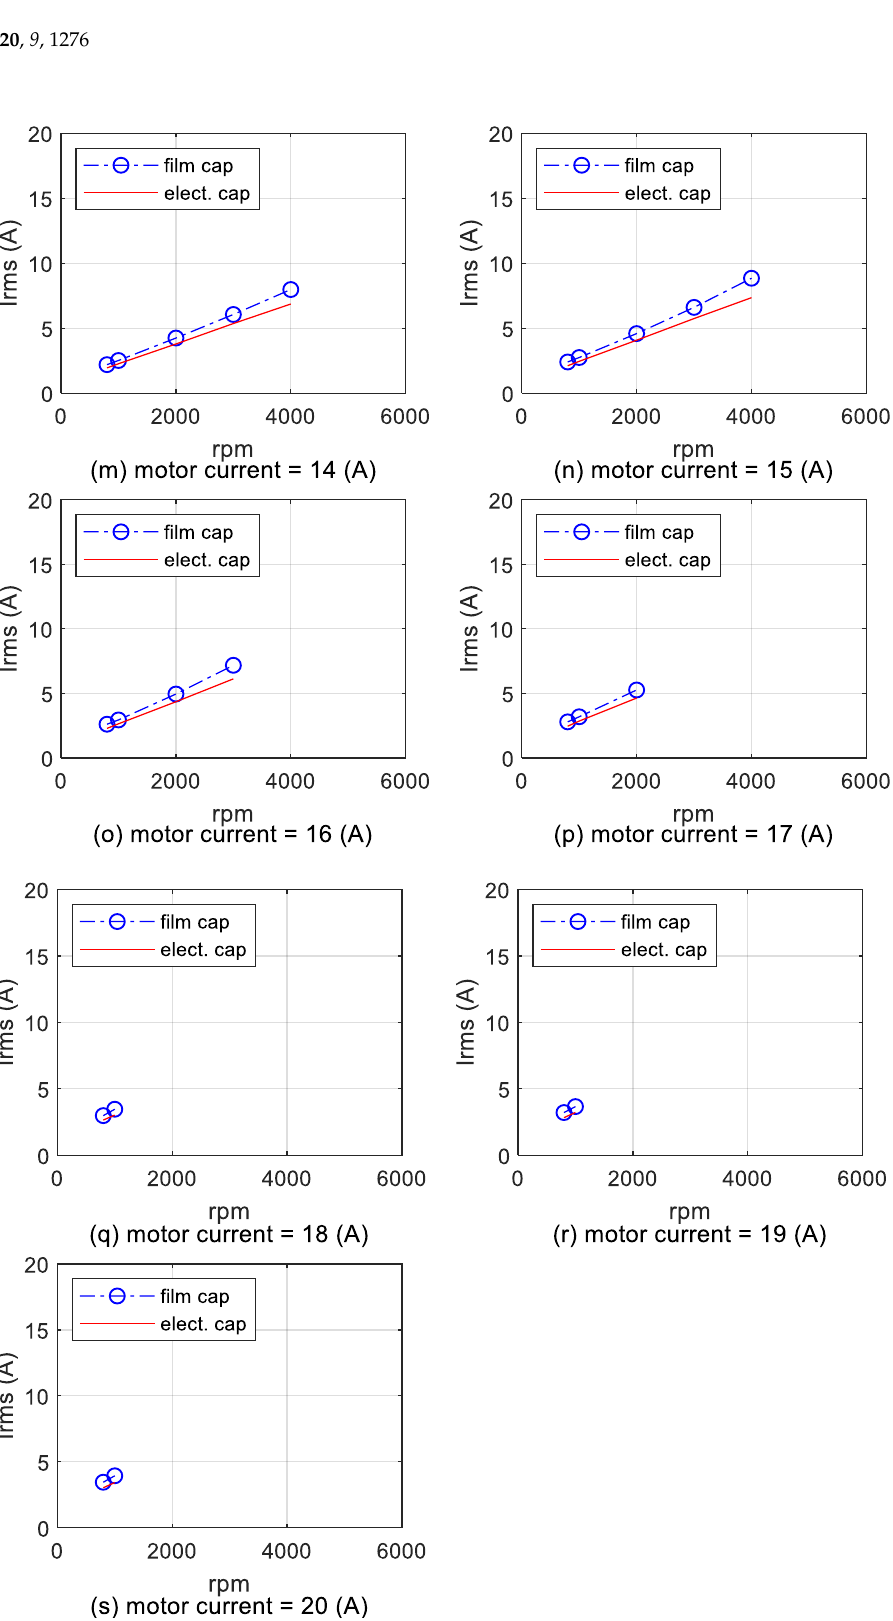
Figure 21. Capacitors RMS current as functions of motor speed.